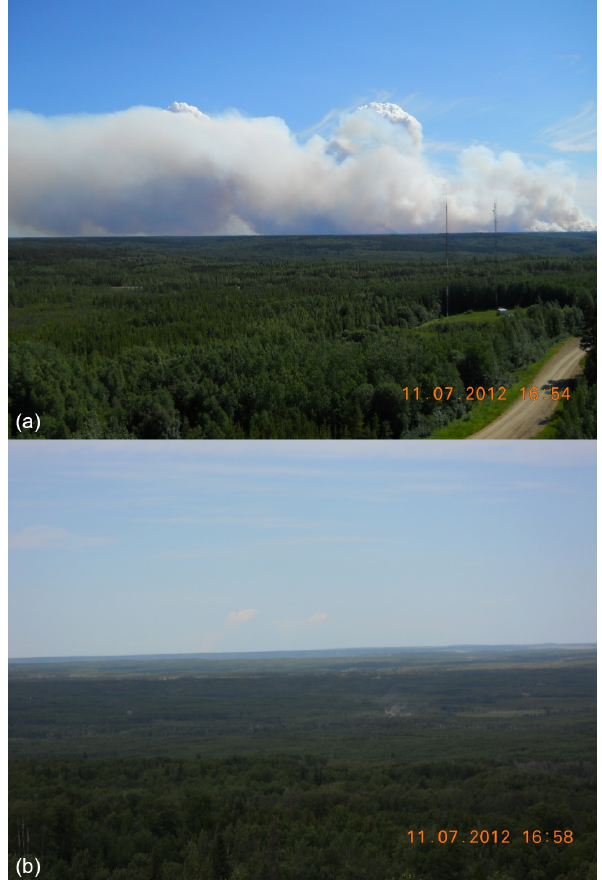
Figure 5. Zoomed-out photograph of plume from fire PWF068 from Hotchkiss at 24km (a) and zoomed-in from Saddle Hills at 173km (b) .